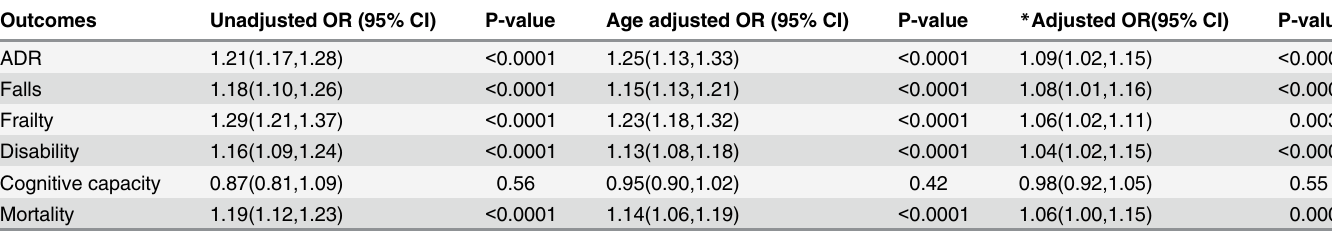
participants in this study using some medication. Mean number of medications in this popula- tion was 9.56±5.68. The prevalence of the most common conditions were hypertension 52.1%, ischemic heart disease 33.5%, diabetes 24.5%, pain 28.7%, chronic kidney disease 16.8%. Benign prostate hypertrophy, stroke, constipation, dyslipidemia and hearing loss made up the rest of the top 10 most prevalent conditions. The top seven most frequently used classes of medications were anti-hypertensives, anti- platelet agents, hypoglycemic agents, analgesics, gastrointestinal agents, purgatives, anti-hyper- lipidaemics. The prevalence of polypharmacy among the participants was 70%. A total of 295 (18.9%) participants were identified as being frail. Disability on activities of daily living was observed in 226(14.5%) of participants, and 202(12.9%) were cognitively impaired. The mortal- ity rate was 5.06% during a mean follow-up period of 60.2months. Falls were reported by (556) 35.6% of participants. Among the survivors, the average number of medicines in use increased from 8.15 to 9.17 (p < 0.001) in the polypharmacy group and from 16.39 to 17.28 in the excessive polypharmacy group during the follow-up (Table 2). At the time of the follow-up survey, an increase in the number of taken medicines had occurred among half of the survivors (50.9%, n = 921). The risk of different outcomes in relation to number of medications rises significantly (Table 3), the odds ratios were 1.21 (95% confidence interval [CI] 1.17 – 1.28) for adverse drug Table 3. ORs of different outcomes in relation to number of medications.